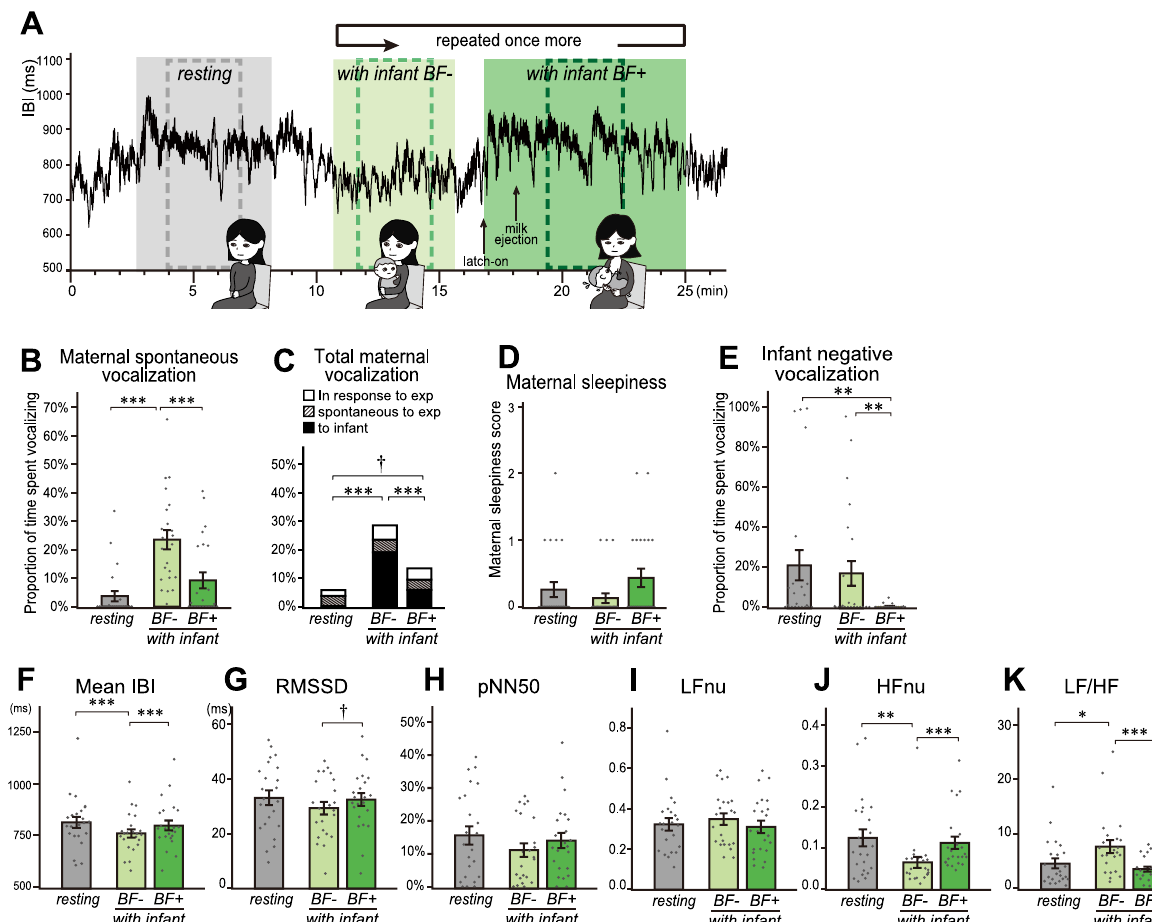
Fig. 2 Breastfeeding-induced calming responses in mothers. A 3-min data from the middle of each condition for 23 of 26 participants were used for this analysis. A The schema for the breastfeeding experiment and an example IBI plot. Mothers sat alone for 5 min ( resting , grey), sat with her infant on lap for 5 min ( BF − , light green), breastfed from one side for some time ( BF + , dark green), and repeated the with infant conditions once more. Vertical arrows indicate the timings when the mother reported the infant’s latch-on and when reported perceiving the milk ejection. IBI and vocalization data in the middle 3 min of these conditions (dashed boxes) were analyzed. B The proportion of the amount of maternal spontaneous vocalization by condition, excluding her replies and reports towards the experimenter. C Proportion of maternal vocalization and its subdivision to the duration of each condition. Each vocalization was categorized by whether it was directed towards the infant or the experimenters, and if the latter, whether it was spontaneous or induced. In B , the sum of “spontaneous to exp” and “to infant” is shown. D Maternal sleepiness scores for each condition, from a post-experiment questionnaire. At the end of the experiment, mothers recalled and chose her level of sleepiness from a range between not sleepy (score: 0) and difficult to stay awake (score: 3) for each condition. E Proportion of infant negative vocalization to the duration of each condition. F–K Heart rate variability measures in the time-domain ( F – H ) and the frequency-domain ( I – K ). Bars represent mean represent individual data points. Multiple comparisons were done by Friedman’s test, and a post hoc Wilcoxon signed-rank test for all pairs, with p -values adjusted by Benjamini–Hochberg’s method, † p < 0.1, * p < 0.05, ** p < 0.01, *** p <